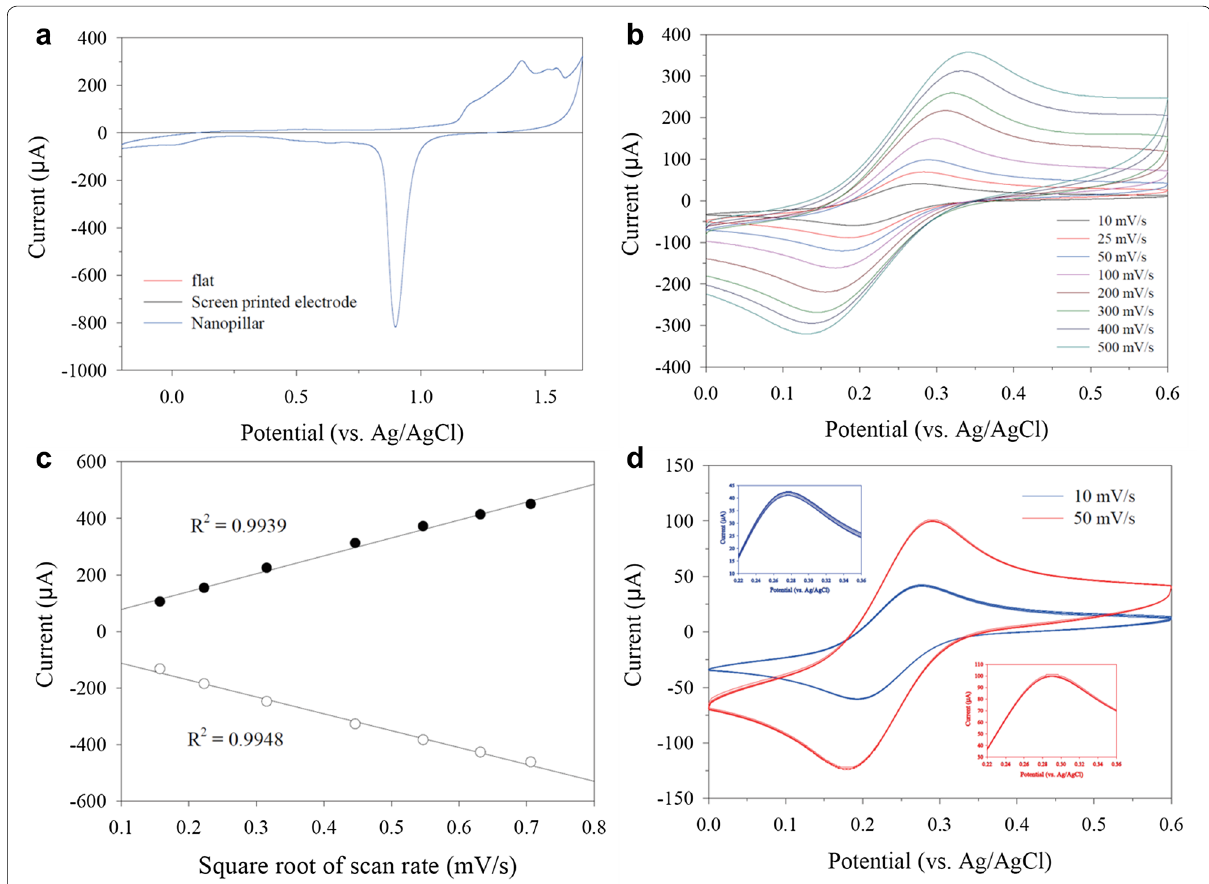
Fig. 2 a The electrochemical behavior of nanopillar electrode in comparison with flat electrode and screen printed electrode using the H 2 SO 4 . b Cyclic voltammogram of NPE in the scan rate range from 10 to 50 mV/s. c Redox peak current from the ( b ). Reproducibility test of NPE at the 10 and 50 mV/s. The 5, 10, 15, 20, 25, and 30 cycle is